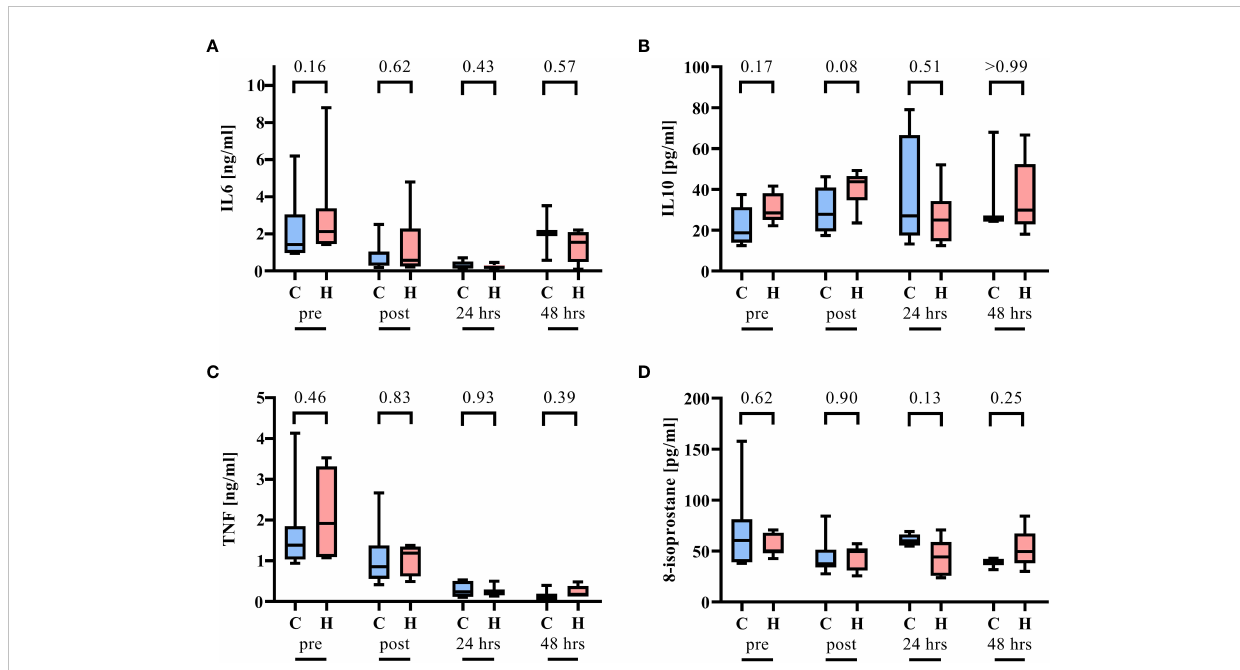
FIGURE 2 In fl ammation parameters before (pre) and after 2 hrs of hemorrhagic shock and acute subdural hematoma (post) as well as 24 hrs and 48 hrs after resuscitation. n = 7/7 before shock, 7/7 after shock, 5/6 at 24 hrs, and 3/5 at 48 hrs per group for normoxemia (blue, control group, C) and targeted hyperoxemia (red, H), respectively. (A) Interleukin 6 (IL6), (B) interleukin 10 (IL10), (C) tumor necrosis factor, and (D) 8-isoprostane. Mann-Whitney U test. The box plots report the median, interquartile range, minimum, and maximum.